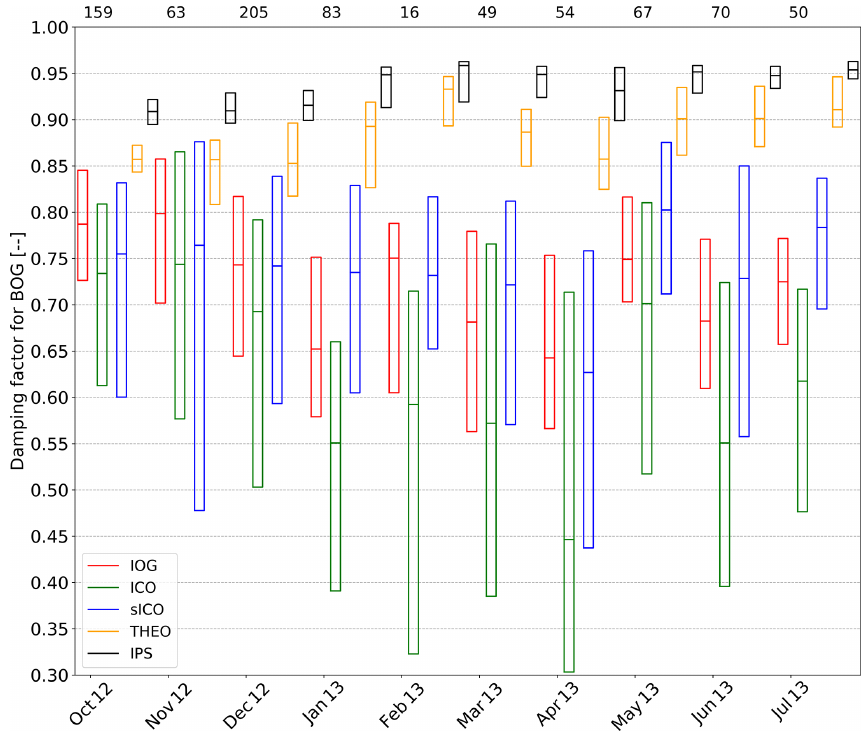
Figure 5. Boxplots of the flux damping factor ( α ) for BOG without whiskers and outliers (the box frame is the 25% to 75% interquartile ranges (IQR); the bold line is the median). The number of observations which are displayed at the top of the plot is the same for every